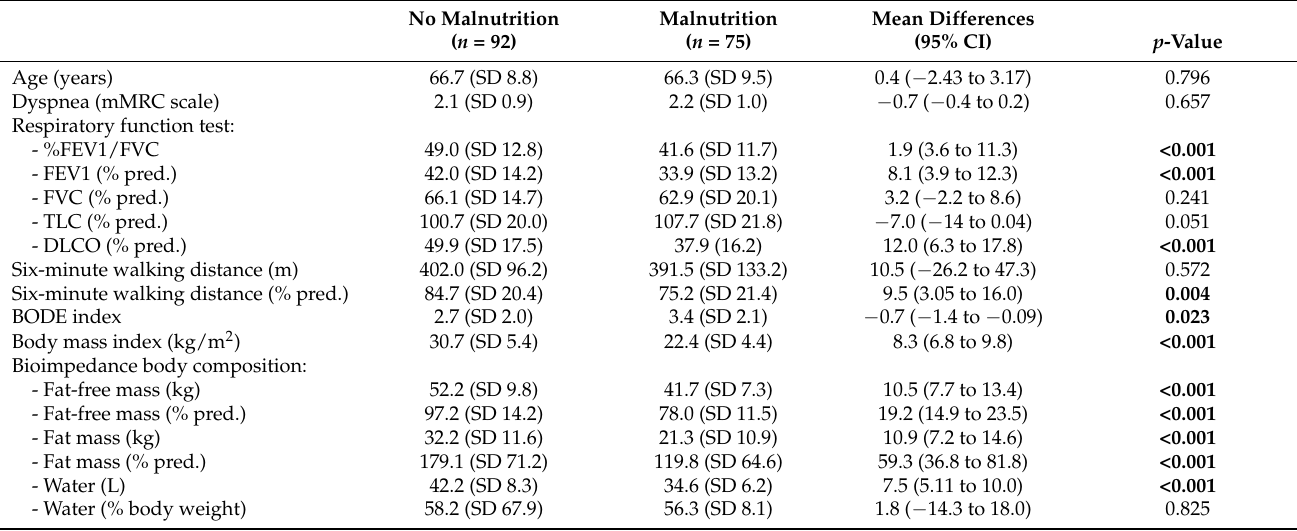
Table 2. Clinical characteristics of the participants according to malnutrition as defined by the Global Leadership Initiative on Malnutrition (GLIM) consensus ( n =